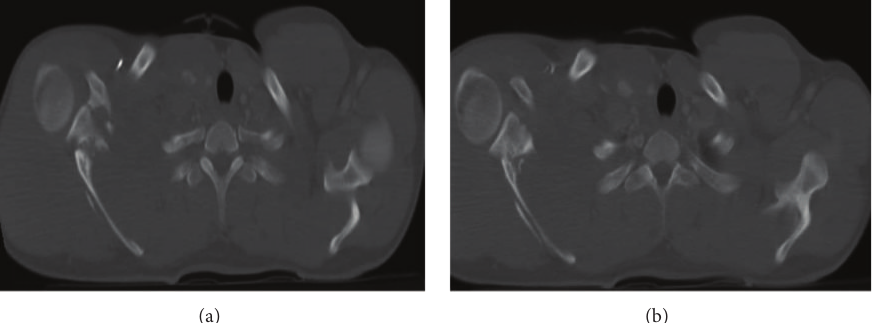
Figure 16: Right scapular fracture. Axial MDCT in bone window ((a), (b)). Comminuted right scapular fracture involving the scapular neck and spine is clearly